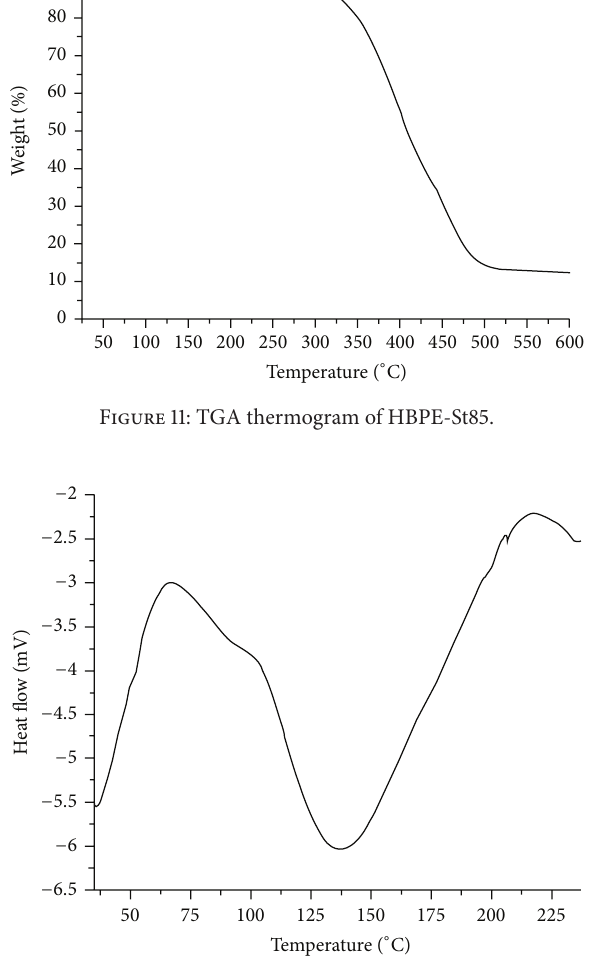
Figure 12: DSC thermogram of